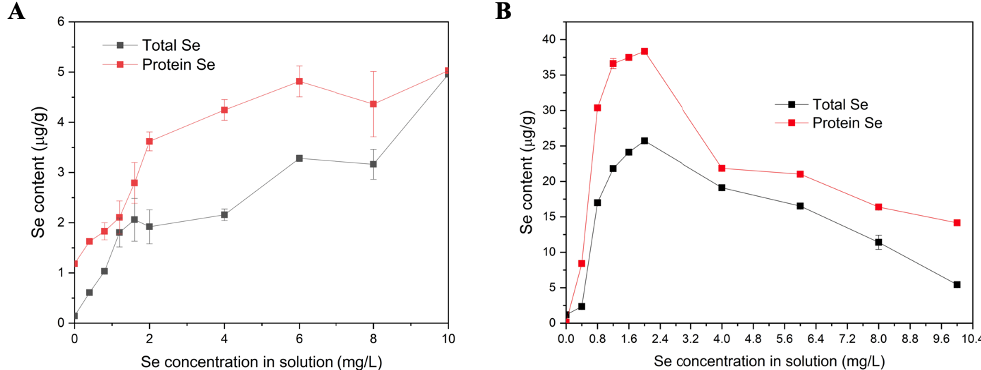
Figure 1. Se contents in SSPs and sweet potato stem powder cultivated by different Se enrichment methods: ( A ) soil application, ( B ) foliar application. Values are means ± SDs ( n = 3).